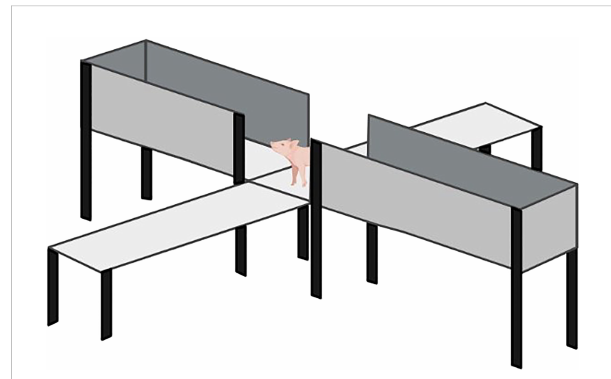
FIGURE 3 Elevated plus maze test adapted (95). The elevated measured 1.2 m long, 0.6 m wide and 0.45 m high.